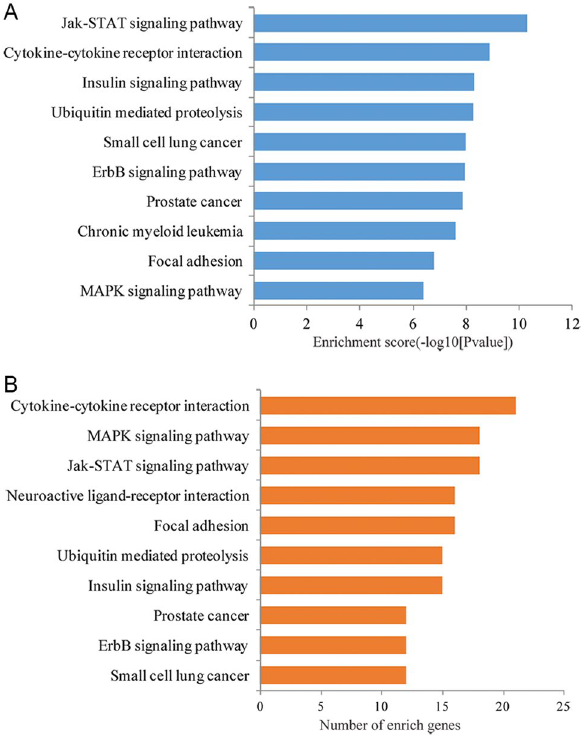
Figure 3. KEGG pathway analysis for the targeted genes of miR-1227-3p. ( A ) KEGG pathway analysis according to the P value. ( B ) KEGG pathway analysis according to the number of target genes included.